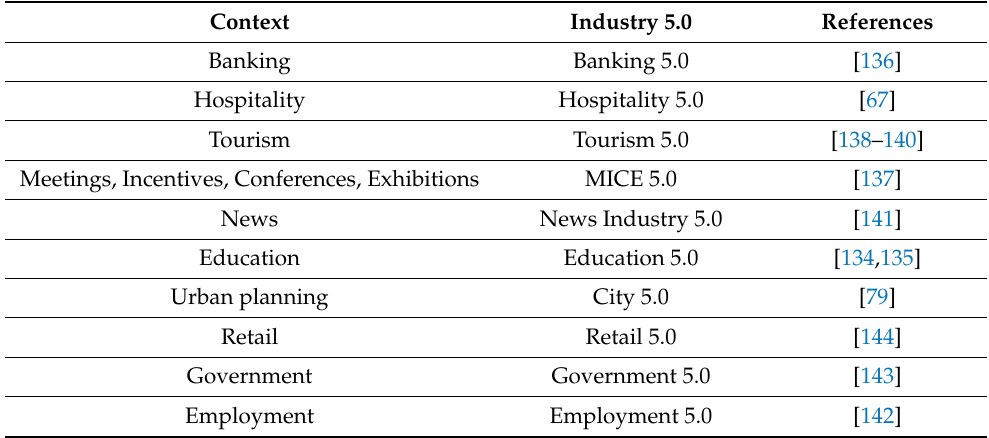
Table 2. Variations of the generic I5.0